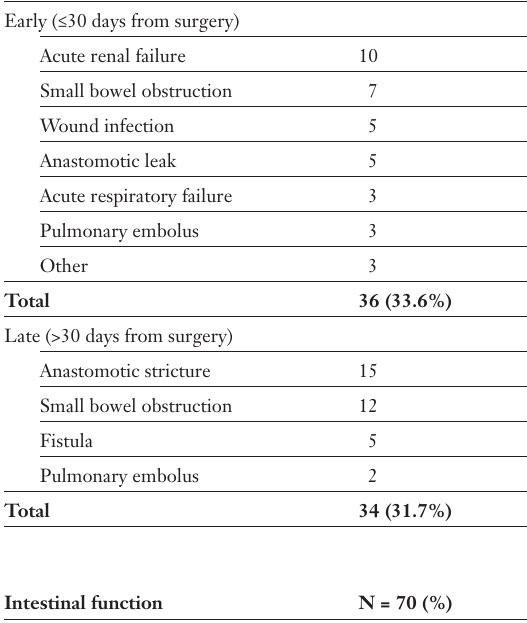
Ileal pouch-anal anastomosis: func- tional results